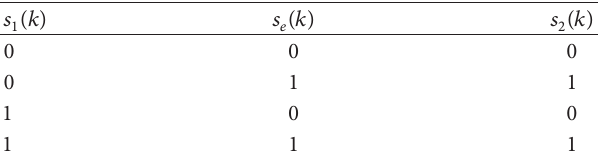
Table 2: Truth table for 𝑠 2 (𝑘)